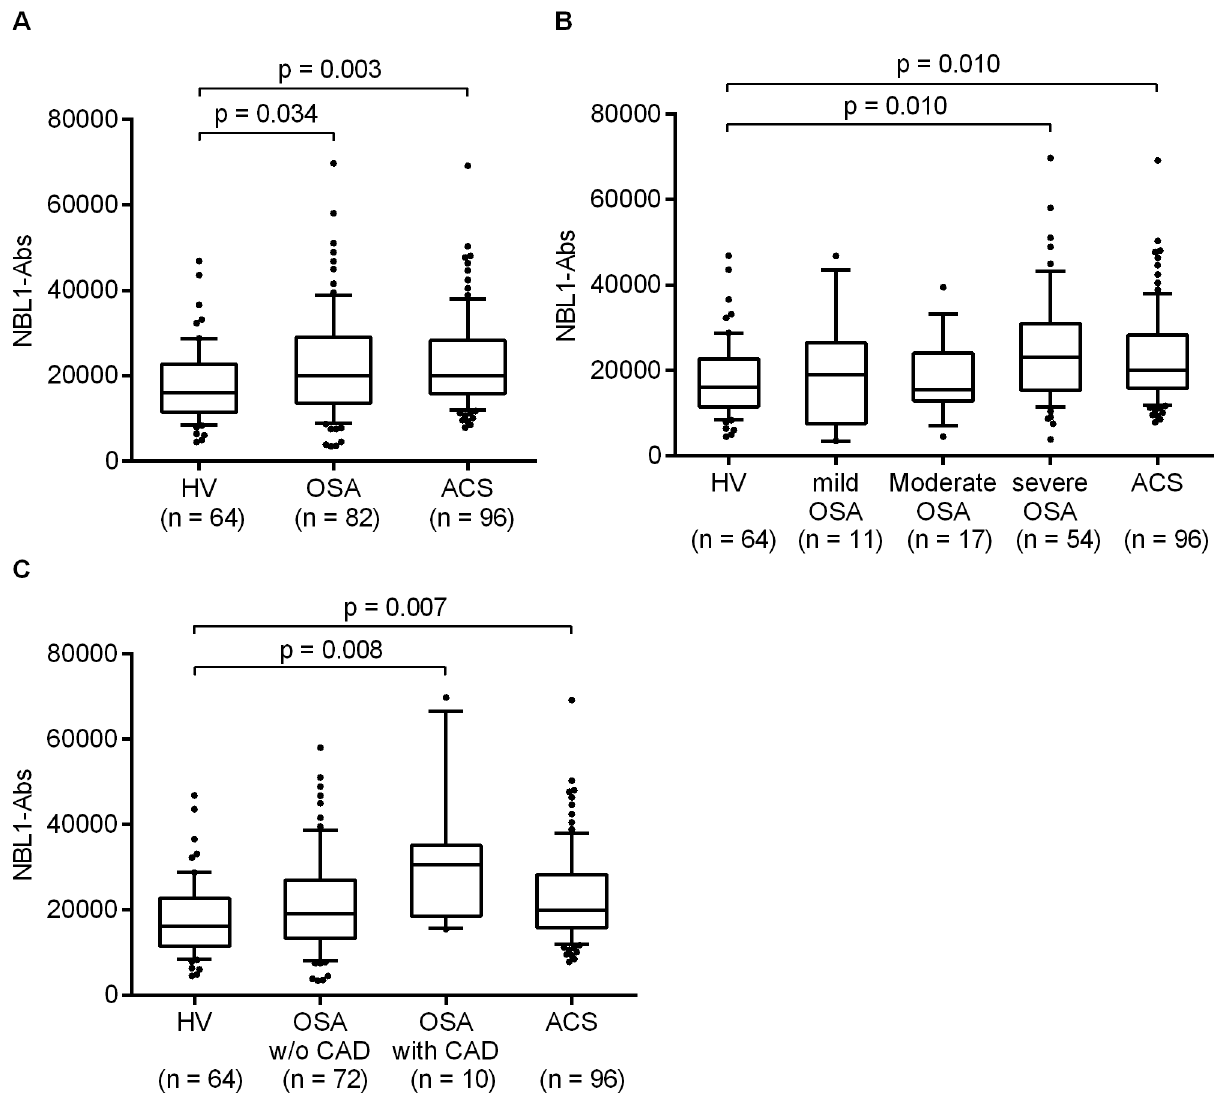
Fig 1. Association between NBL1-Ab level and disease. Pooled OSA group data were compared with those of patients with ACS and HVs. Significant differences were observed among the three groups using the Kruskal—Wallis test (p < 0.004). Post hoc analysis using the Steel—Dwass test revealed significant differences between both patients with OSA and ACS and the HVs (Fig 1A). Patients with OSA were stratified by OSA severity (Fig 1B) or by having a history of CAD (Fig 1C) and then compared with patients with ACS and HVs. Significant differences were observed in both comparisons using the Kruskal—Wallis test (p < 0.003 and p < 0.001). Post hoc analysis using the Steel—Dwass test revealed significant differences between both patients with severe OSA and OSA patients with CAD versus HVs. Horizontal lines represent medians, boxes represent the 25th and 75th percentiles, whiskers represent the 10th and 90th percentiles and dots represent outliers. ACS, acute coronary syndrome; CAD, coronary artery disease; HV, healthy volunteer; NBL1-Abs, autoantibodies against NBL1; OSA, obstructive sleep apnea; w/o, without.